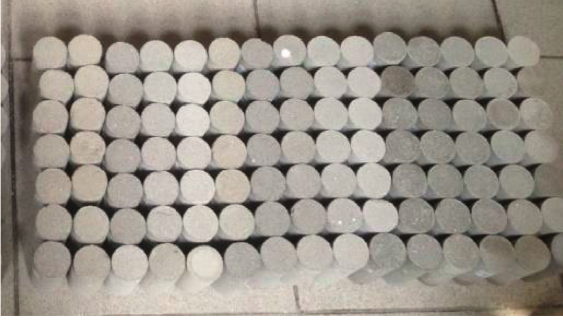
Figure 2: The maintained specimen. Table 4: Orthogonal experiment results of the similar material